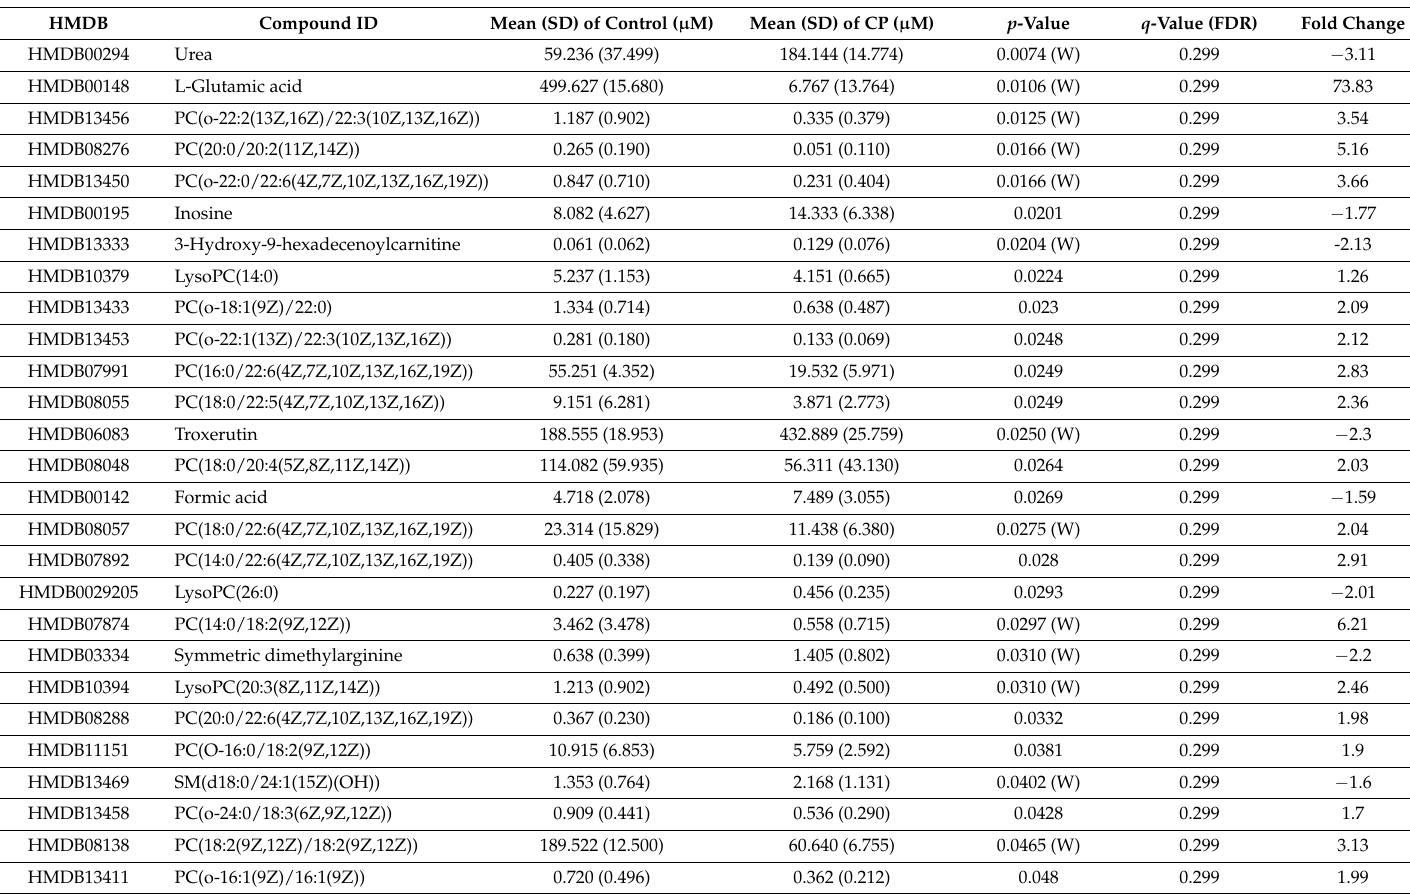
Table 1. Statistically significant metabolite concentrations ( µ M; p < 0.05; q < 0.05) for CP vs control PM brain extracts. t -test values were calculated as a default and values with (W) were calculated using the Wilcoxon–Mann–Whitney